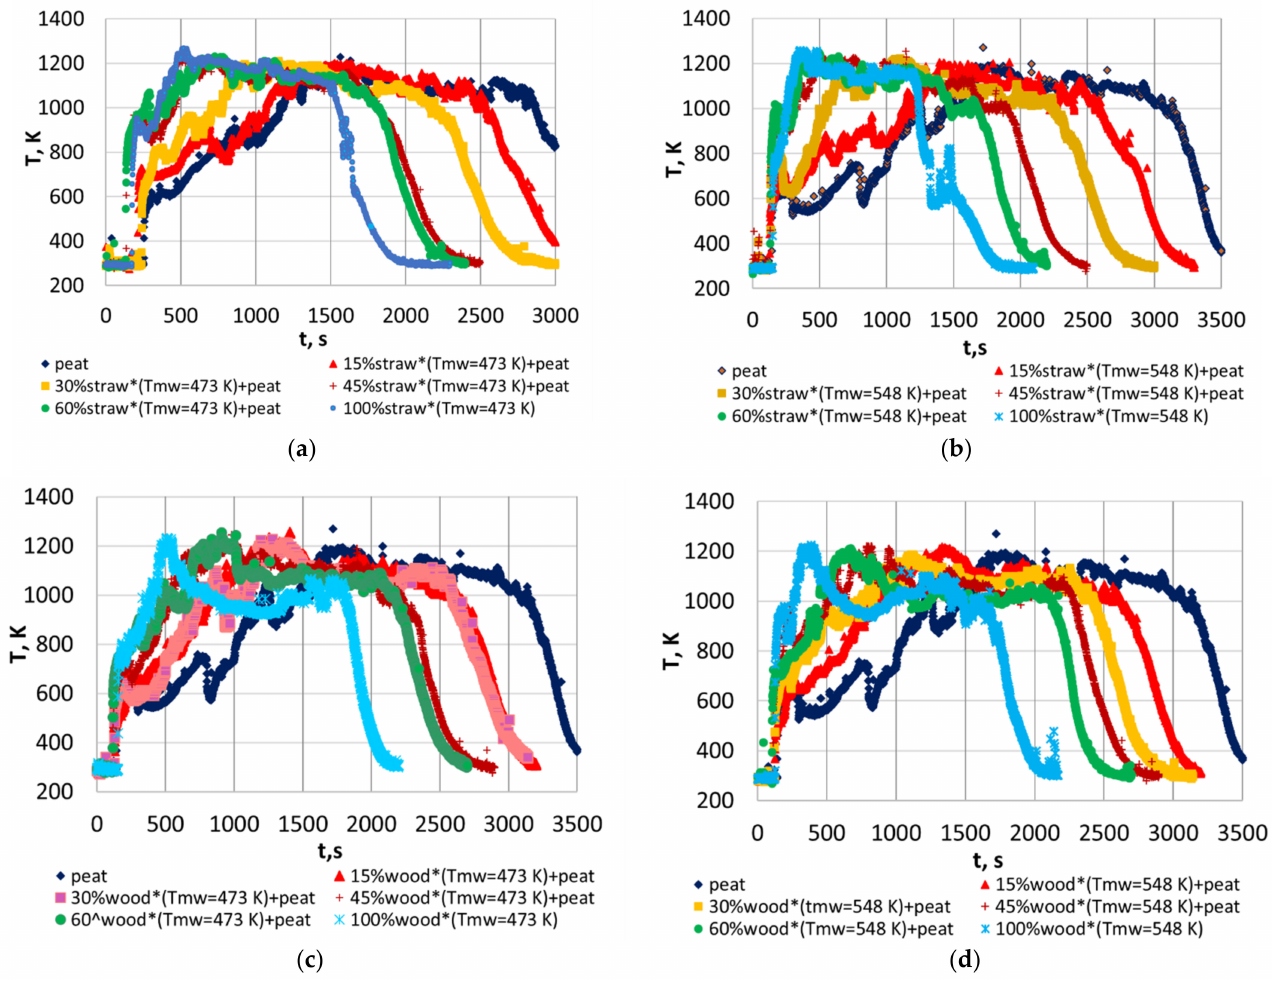
Figure 3. Effect of changes (variations) in pre-treatment temperature and composition of selectively pre-treated wheat straw* ( a , b ) and wood* ( c , d ) blends with raw peat pellets on the kinetics of the flame temperature.